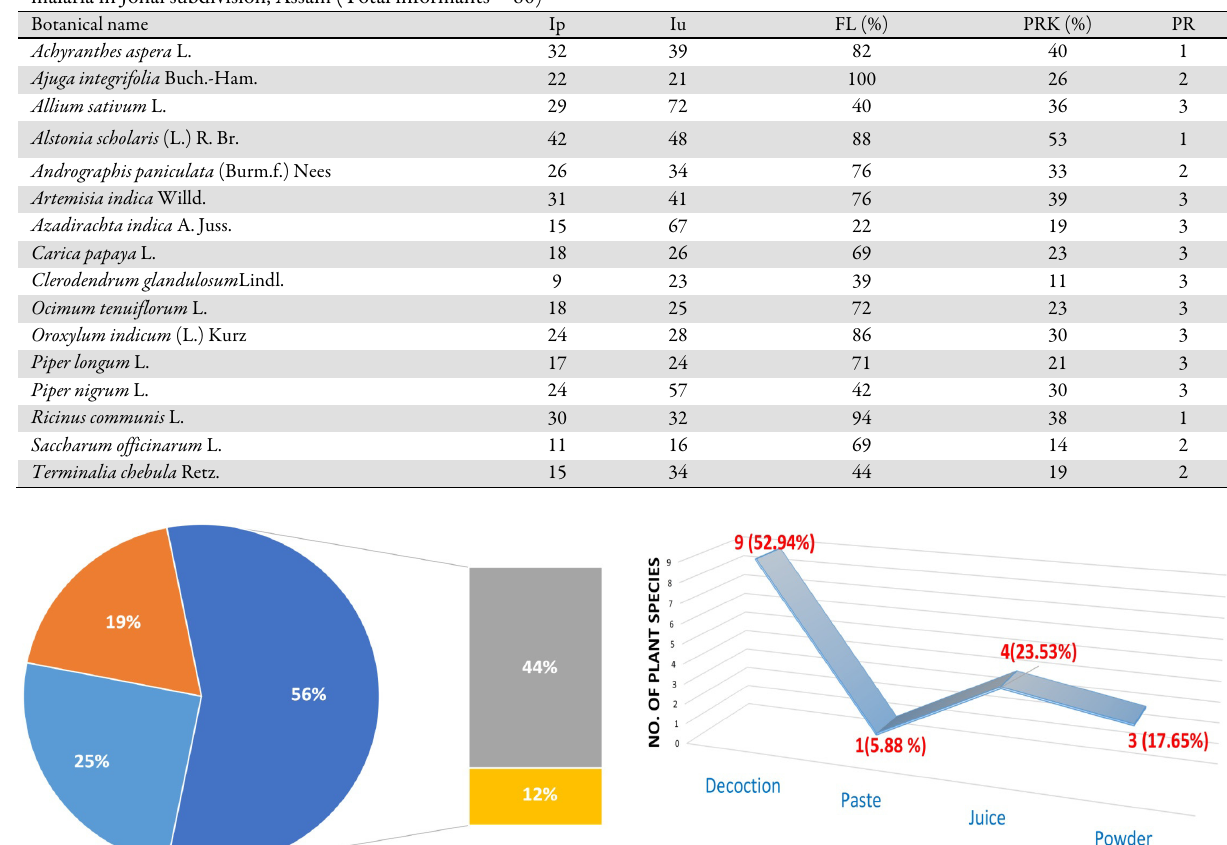
Table 2. Fidelity level (FL), PPK (Percentage of respondents who have knowledge) and PR (Preference ranking) of species used to treat malaria in Jonai subdivision, Assam (Total informants = 80)